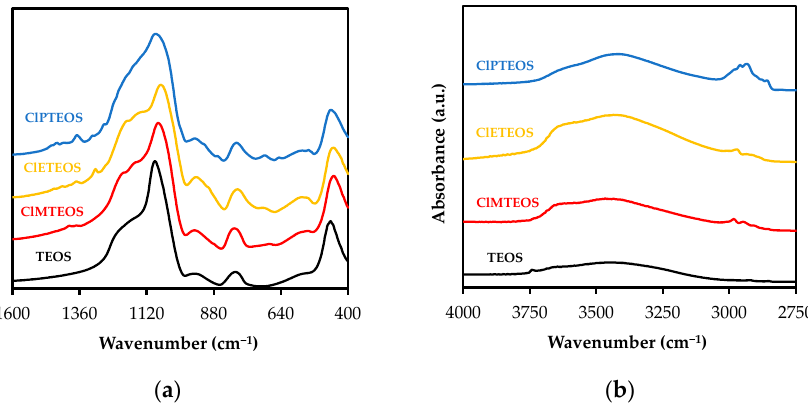
Figure 2. FTIR spectra of TEOS xerogel and TEOS:ClRTEOS hybrids (molar ratio, 20%): ( a ) range from 1600 to 400 cm − 1 , and ( b ) range from 4000 to 2750 cm − 1 .